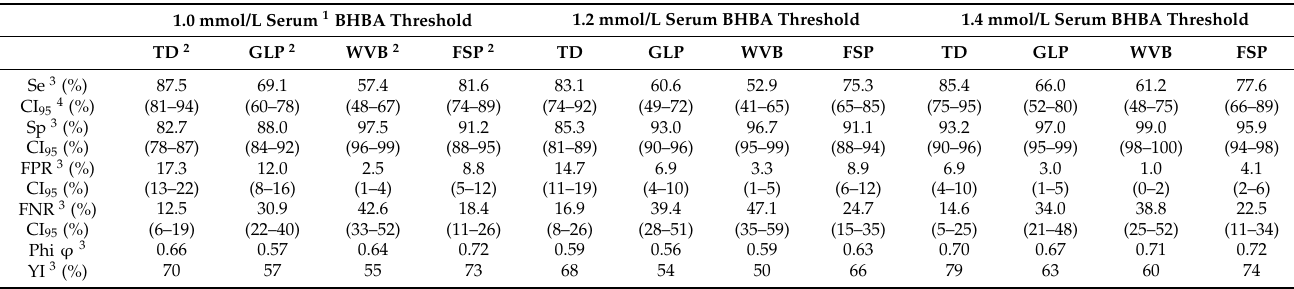
Table 2. Performance of handheld devices measuring β -hydroxybutyrate (BHBA) in whole blood from coccygeal vessels, based on thresholds of ≥ 1.0, ≥ 1.2, and ≥ 1.4 mmol/L BHBA in serum for the detection of subclinical ketosis in whole blood from coccygeal vessels. Blood samples were taken from 100 post-partum Holstein-Friesian dairy cows within 5 to 38 days after calving on four days (test days 2, 4, 9, and 11) during the